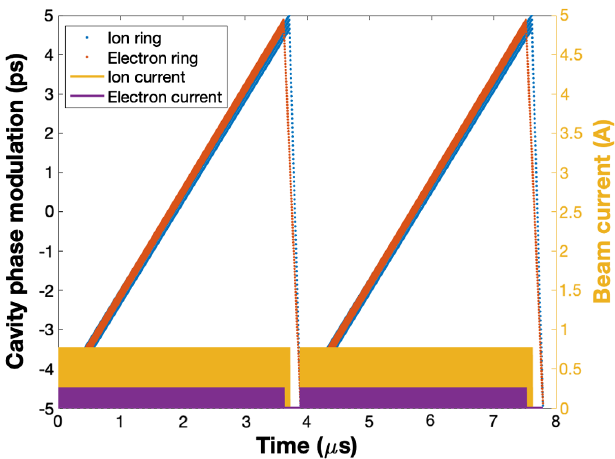
FIG. 18. Phase modulation with electron ring beam filling pattern